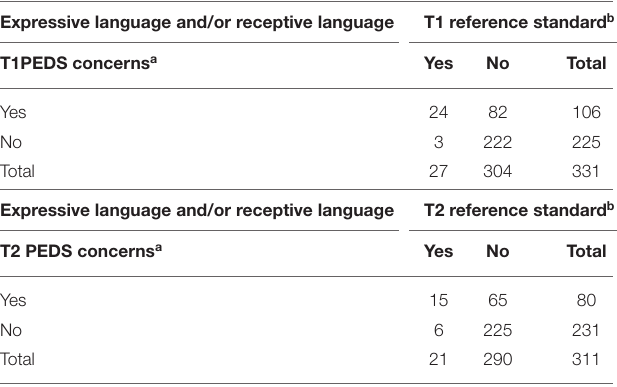
TABLE 2 | Prevalence, Positive, and Negative Predictive Value of PEDS concerns about language development at the age of 3 and 4 years. Expressive language and/or receptive language